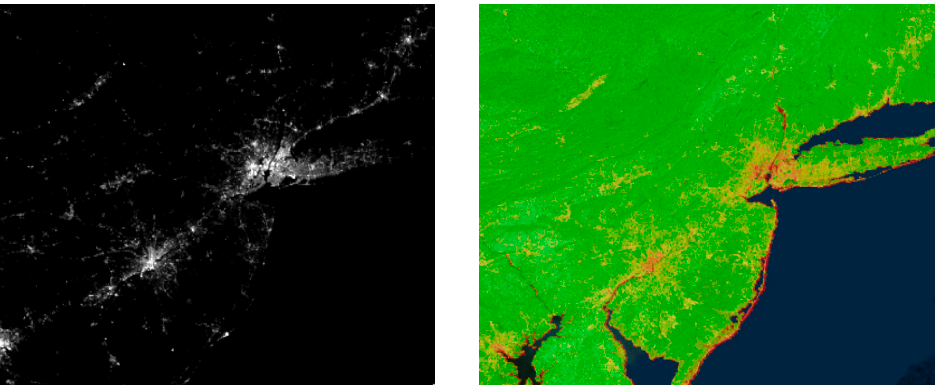
Figure 3. ( Left ) An example of VIIRS nighttime light annual composite for the northeastern United States with stray light, lightning, lunar illumination, cloud-cover, and gas flares removed (urban areas are characterized by brighter pixel clusters); ( Right ) an example of MODIS NDVI annual composite for the northeastern United States with cloud contamination removed using the greenest pixel method (urban areas are characterized by NDVI pixel clusters with lower positive values).